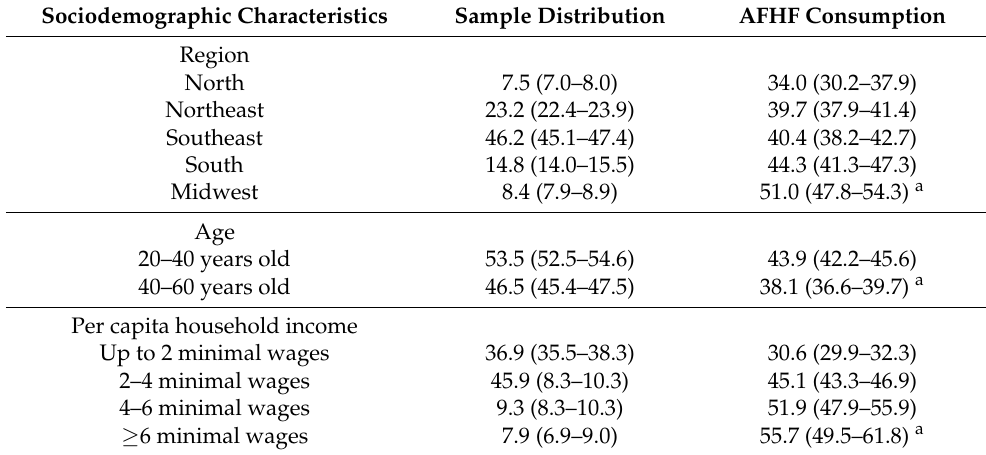
Table 1. Sample distribution and frequency of away-from-home food (AFHF) consumption, according to sociodemographic characteristics. Brazilian adults in urban areas, 2017–2018 (n = 22,780). Sociodemographic